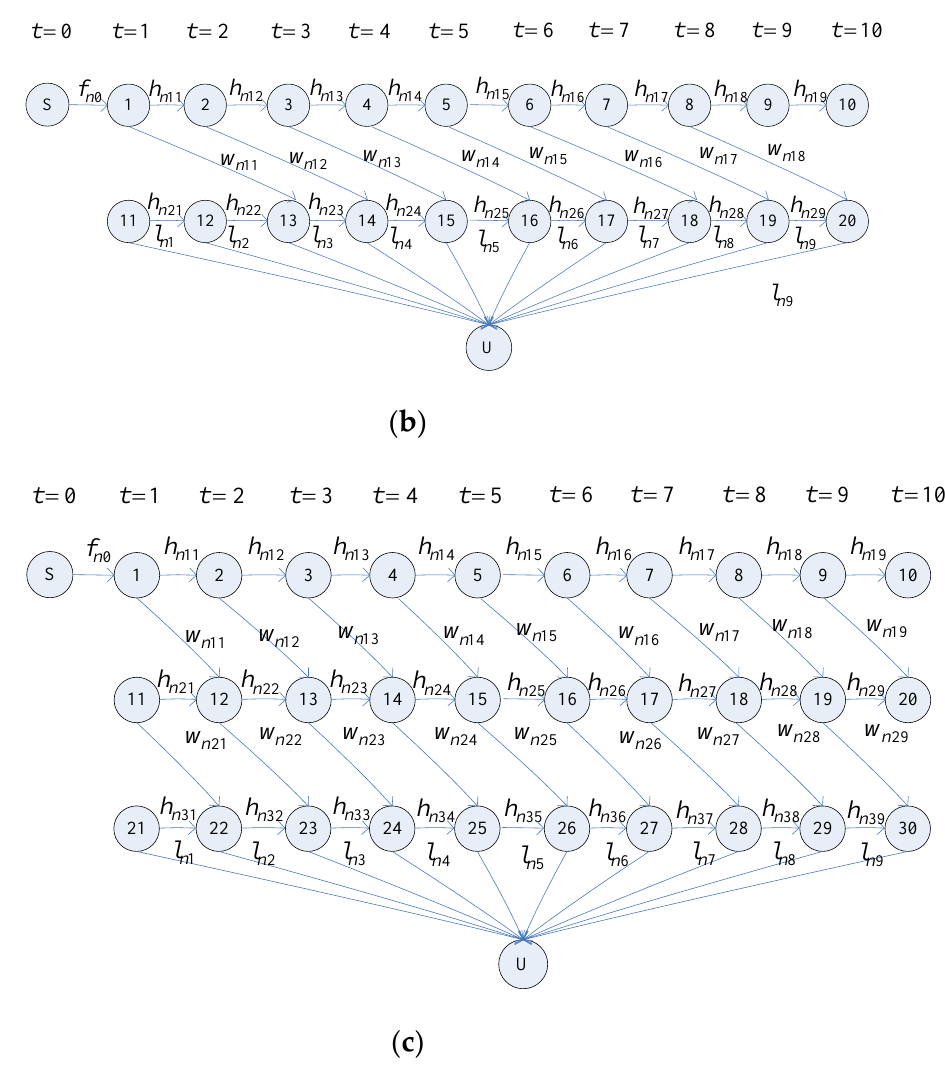
Figure 11. ( a ) The DG 1 ( V 1 , E 1 ) obtained based on DTPN Ψ 1 ; ( b ) The DG 2 ( V 2 , E 2 ) obtained based on DTPN Ψ 2 ; ( c ) The DG 3 ( V 3 , E 3 ) obtained based on DTPN Ψ 3 Note